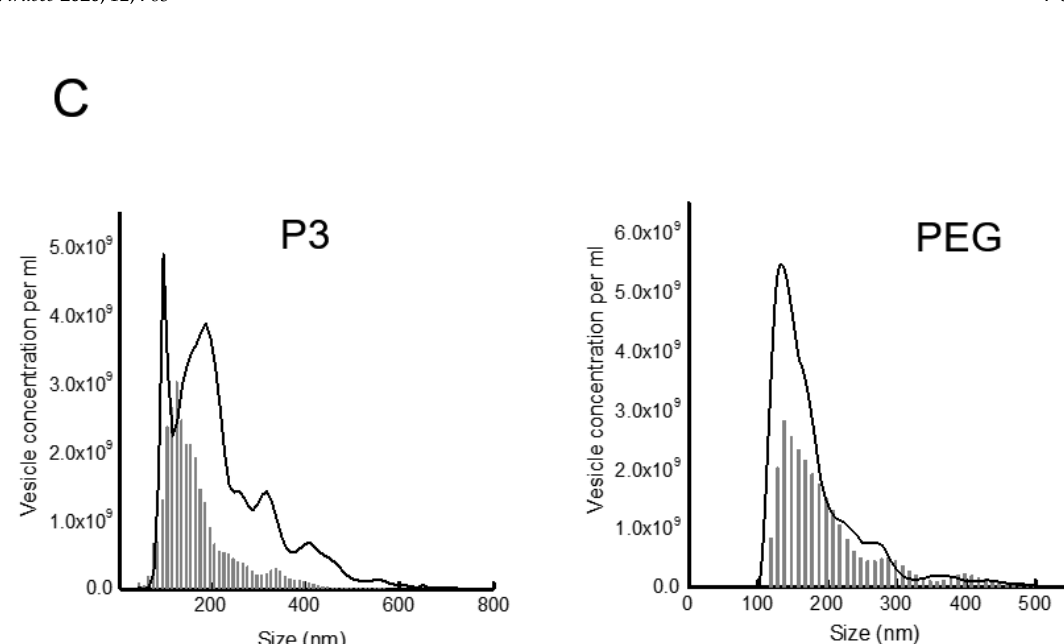
Figure 2. Rotavirus infection increases the secretion of extracellular vesicles in Caco-2 cells. ( A ). Schematic description of the di ff erential centrifugation protocol used. Supernatants collected from Caco-2 cells infected with rotavirus strain RRV were centrifuged at di ff erent speed, to separate distinct size vesicles. At 500 × g , pellet 1 (P1) was obtained; at 2000 × g , pellet 2 (P2); at 9600 × g , pellet 3 (P3); and after PEG 6000 incubation and centrifugation at 9600 × g , the fraction labeled as PEG was obtained. ( B ). Caco-2 cells were infected or mock-infected with strain RRV (MOI of 1) and the supernatants were collected and processed by di ff erential centrifugation as described in A. The same volume of each fraction from infected and mock-infected cells were separated by PAGE, and proteins were detected by silver staining. The apparent molecular weight of some marker proteins (MW) is shown. ( C ) The P3 and PEG fractions were resuspended in PBS for nanoparticle tracking analysis in the NanoSight NS300. In each experiment, five videos were recorded and used for analyses. The average of four independent experiments is shown. The black bars represent vesicles purified from mock-infected cells; grey line represents vesicles purified from infected cells. In the case of PEG fraction, due to size of free viral particles (approximately 100 nm), all particles bellow 110 nm have been removed to avoid their detection.